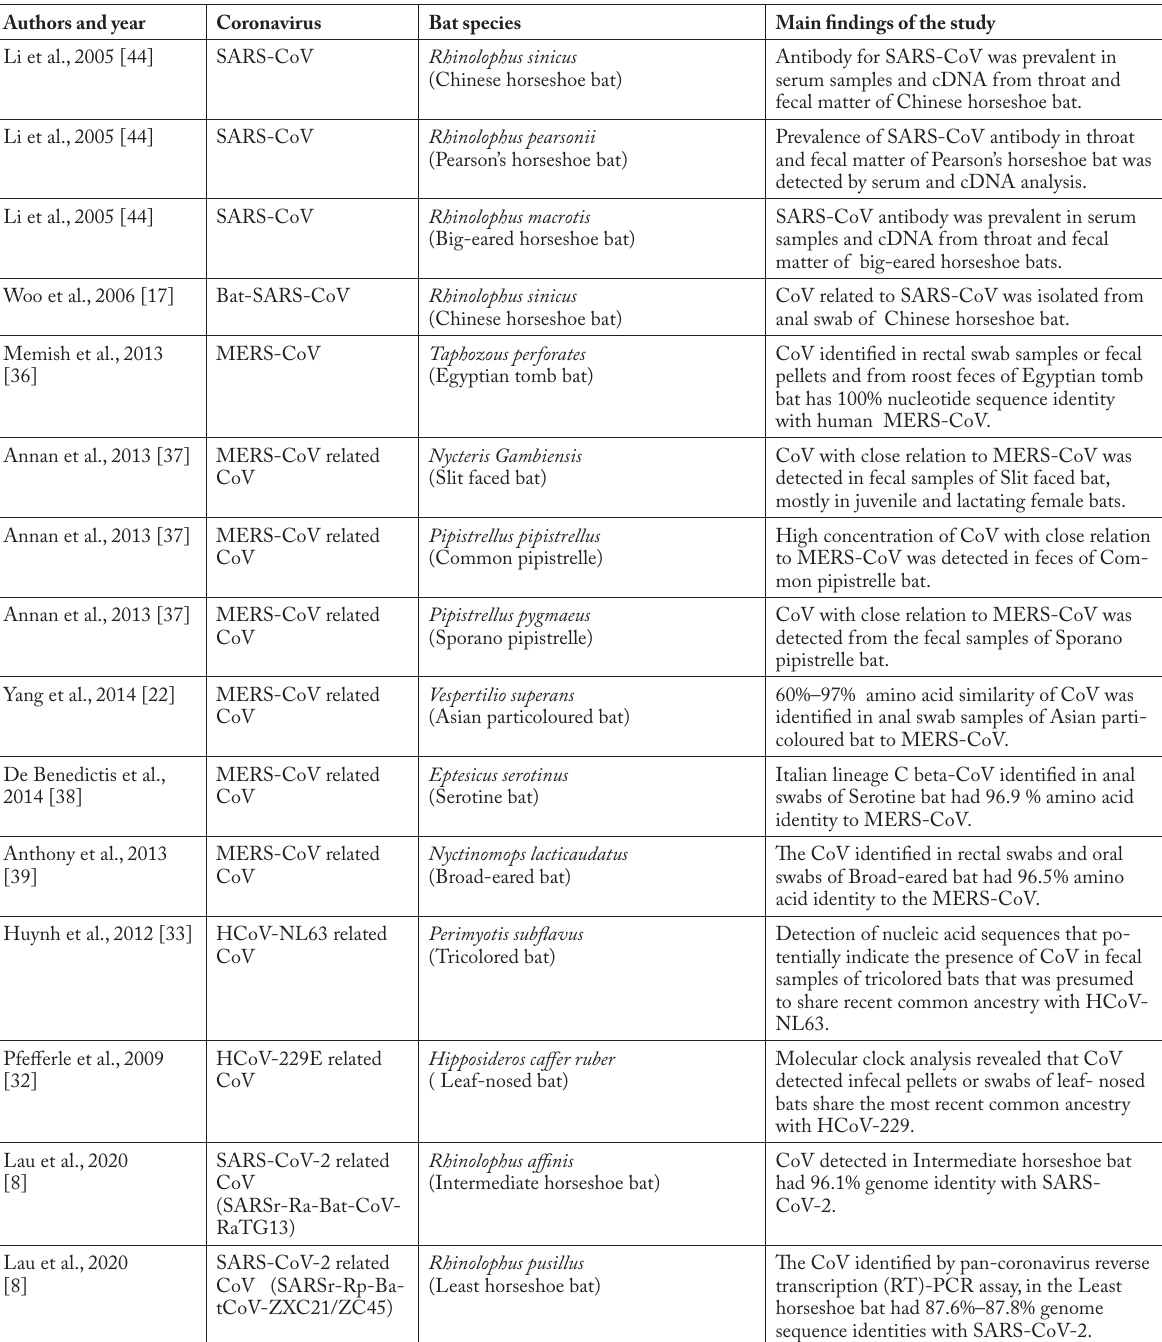
Table 1. Human coronavirus and related coronaviruses in